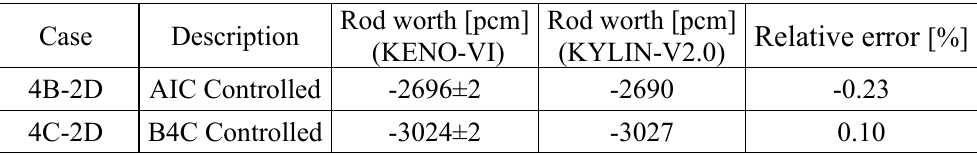
Table V. Calculation result of control rod reactivity worth.